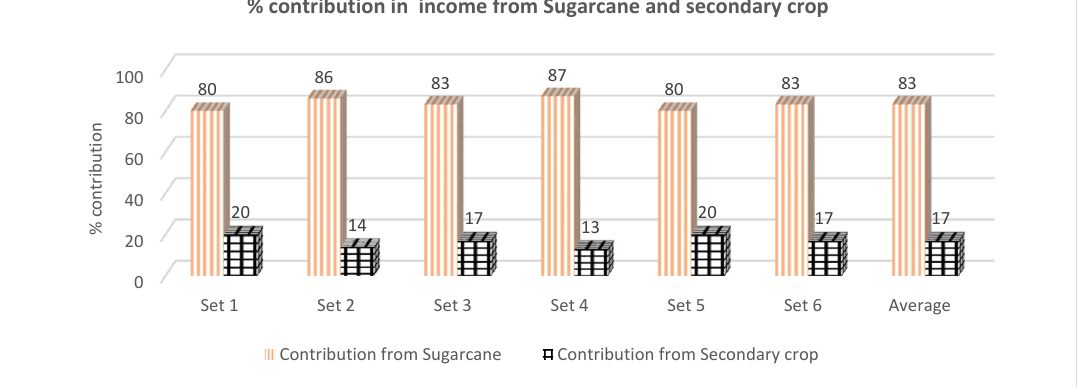
Figure 11. The percentage contribution of sugarcane and secondary crops in total income.